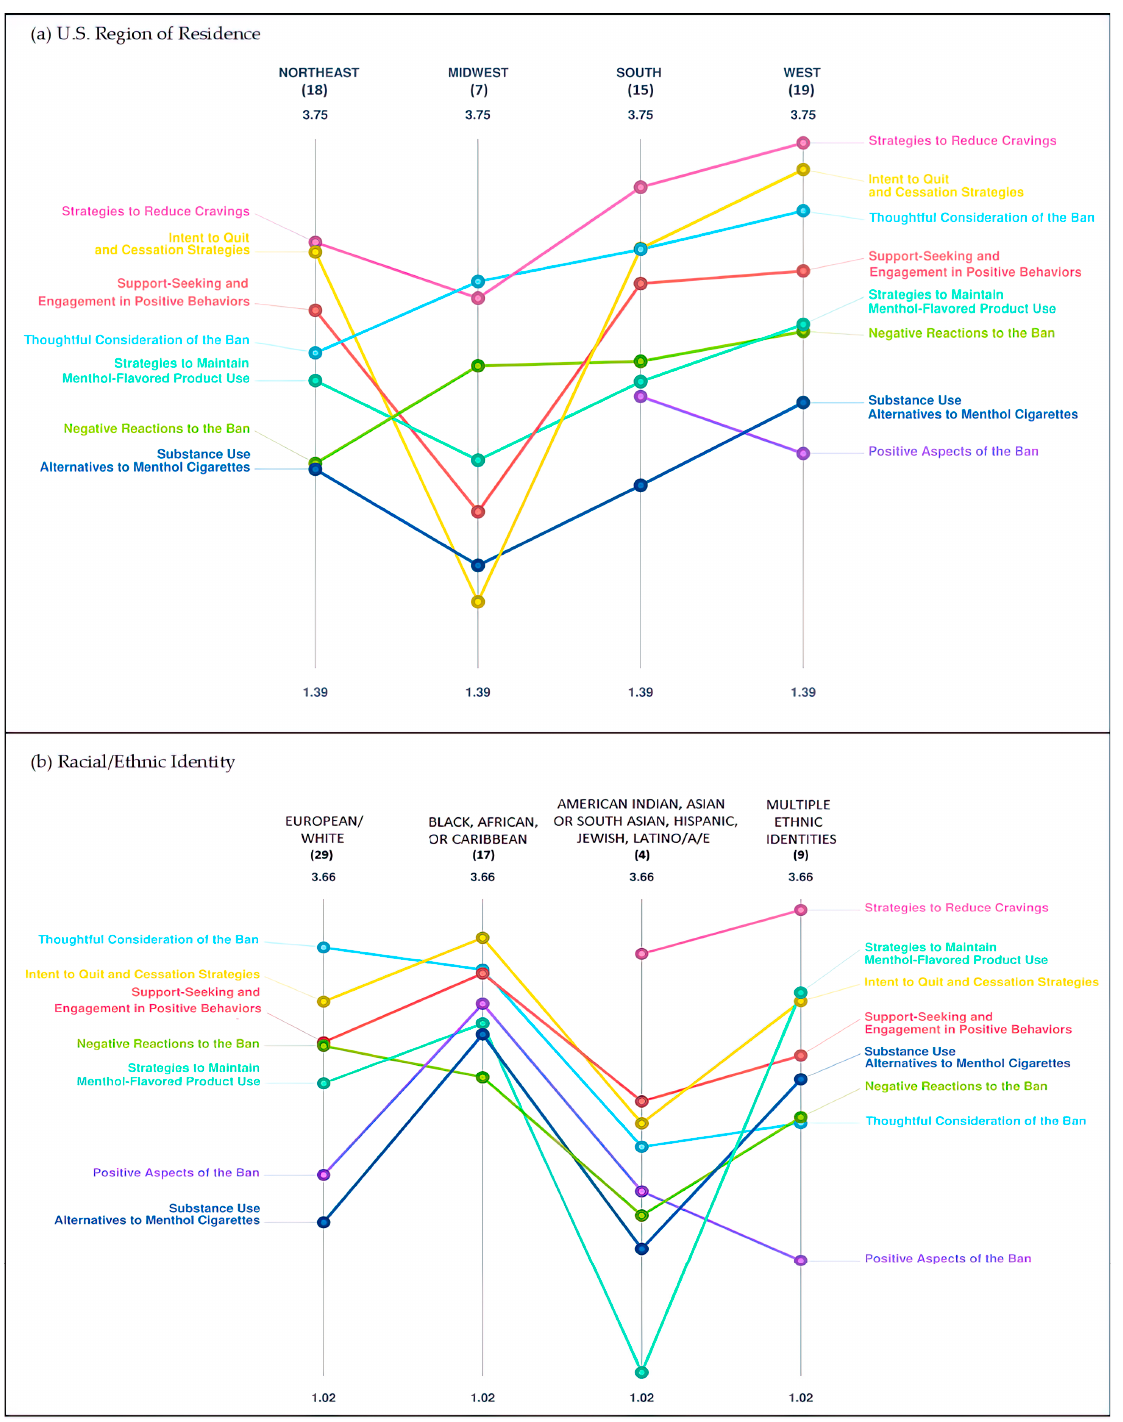
Figure 2. ( a , b ) Pattern-matching results comparing cluster rating averages for multi-level demo- graphic variables: ( a ) U.S. region; ( b ) racial/ethnic identity. Numbers in parentheses represent subgroup sample